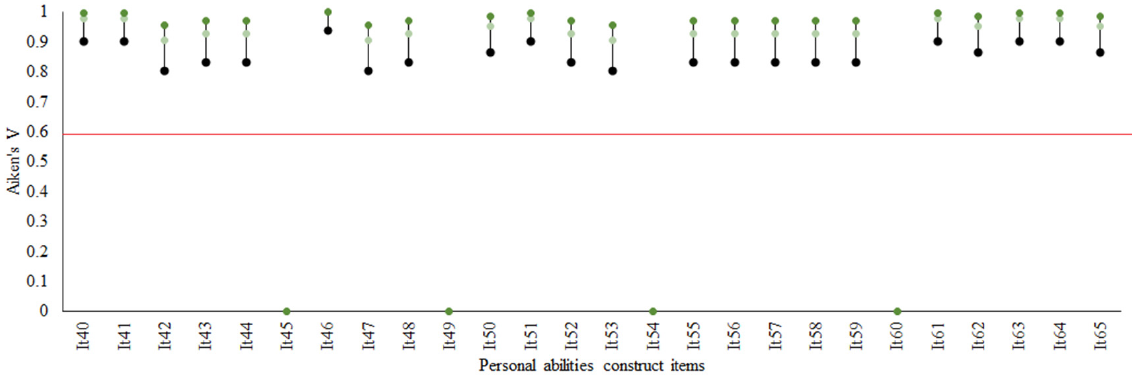
Figure 2. Aiken’s V and confidence intervals for relevance as evaluated by expert-judges ( n = 7) according to the Accessibility construct.